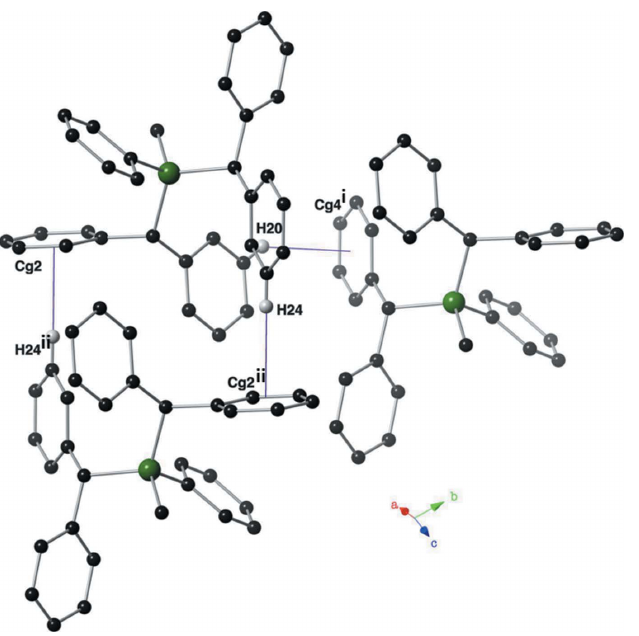
Figure 4 Intermolecular C—H (cid:2)(cid:2)(cid:2) (cid:2) interactions present in the crystal of compound I ; see Table 1 for details. Only hydrogen atoms H24 and H20 are shown for clarity, and the C—H (cid:2)(cid:2)(cid:2) (cid:2) interactions are depicted as purple lines. Symmetry codes: (i) (cid:4) x + 2, (cid:4) y , (cid:4) z ; (ii) (cid:4) x + 2, (cid:4) y + 1, (cid:4) z .